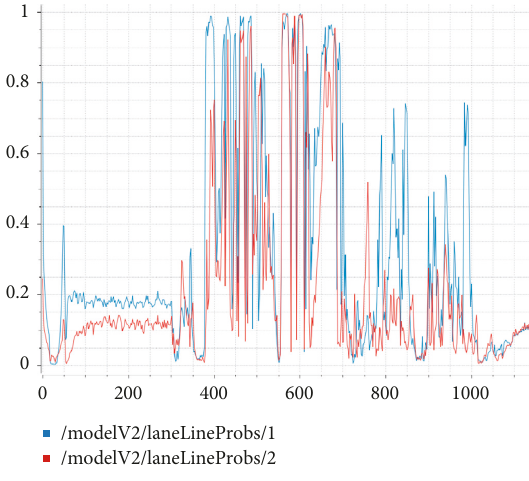
Figure 35: T1N2 left (1) and right (2) lane recognition.